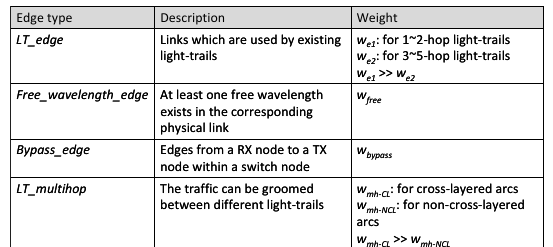
TABLE 2. Types of edges in E A and the corresponding